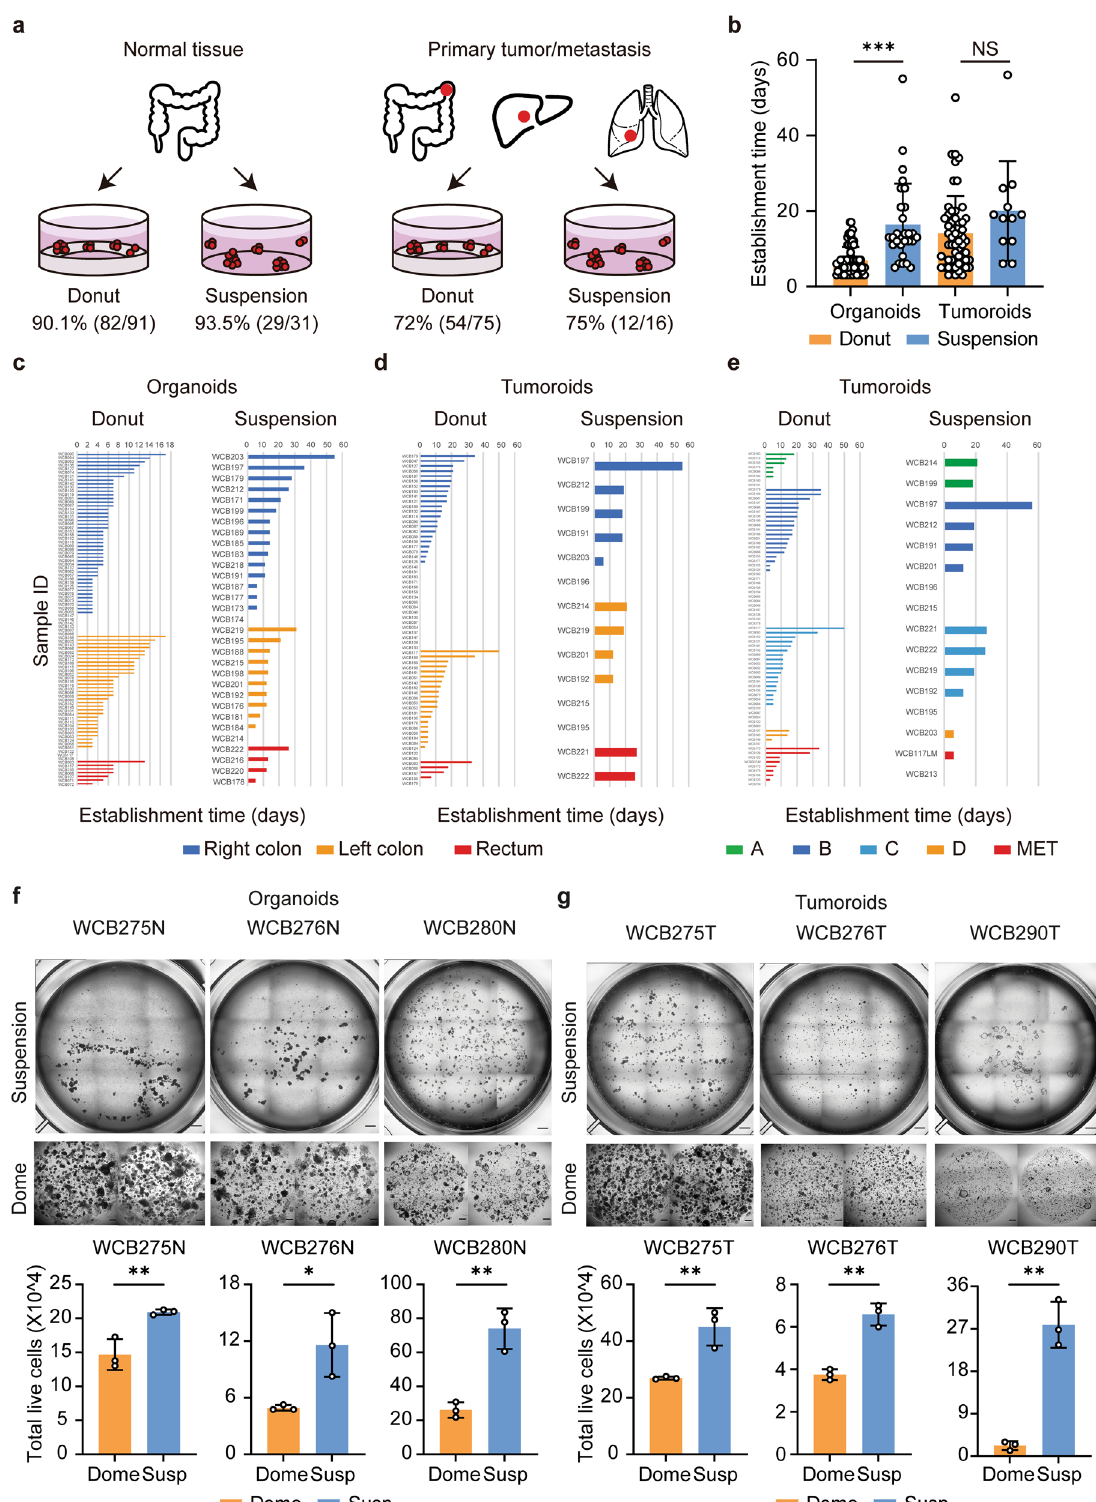
Fig. 6 Establishment of colorectal organoids and tumoroids in low-viscosity matrix suspension culture. a – b , Comparison of ( a ) establishment rates and ( b ) times (passage 0 to 1) between LVM suspension and donut culture methods for organoids ( n = 31 and n = 91, respectively) and tumoroids ( n = 16 and n = 75, respectively). c – e Comparison of establishment times for organoids and tumoroids grown in LVM suspension or donut culture according to ( c , d ) location and ( e ) tumor stage. f – g Comparison of live-cell yield for ( f ) organoids and ( g ) tumoroids from three patients grown for 14 days in LVM suspension or dome culture; scale bars, 500 μ m. Data ( b , f , g ) are plotted as mean ± s.d. Statistical signi fi cance ( b , f , g ) was attributed to values of p < 0.05 as determined by the Student ’ s t test. NS, p > 0.05, ** p < 0.01, *** p < 0.001. N, normal; T,